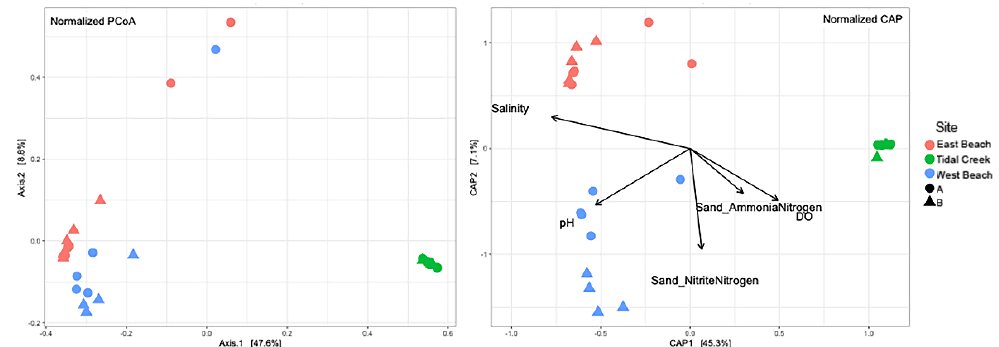
Fig. 2: Principal Coordinates Analysis using the Bray-Curtis distance matrix of normalized sediment bacteria communities (a-left) and the Constrained Analysis Plot (CAP) evaluating the influence of environmental parameters (b-right).